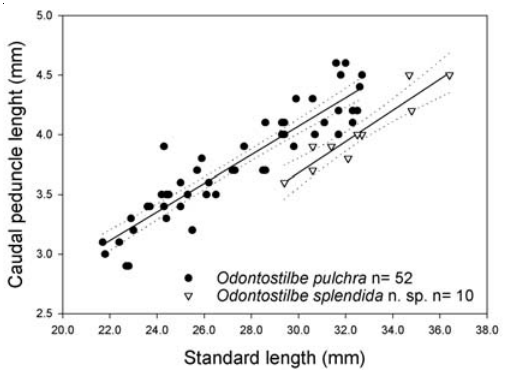
Fig. 14. Anal-fin base as a function of standard length for males of Odontostilbe pulchra , against O. splendida .